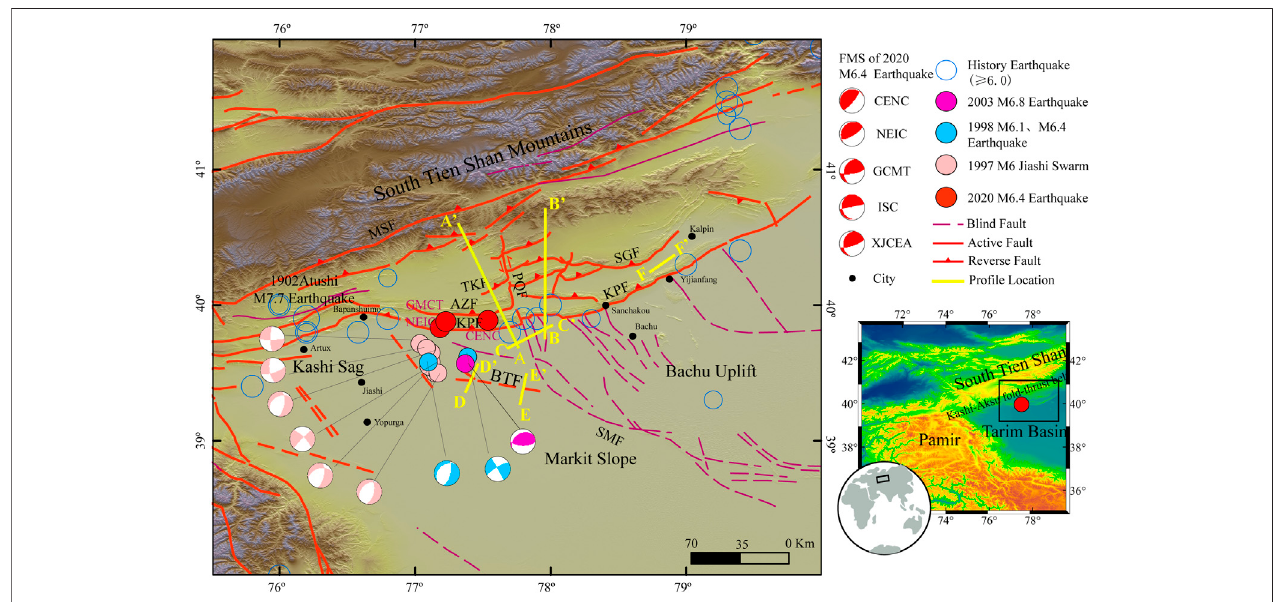
FIGURE 1 | Regional geological settings of the 2020 Jiashi earthquake. The red circles represent the epicenters of the 2020 Jiashi earthquake determined by differentinstitutions.Thebluecircles,thepurplecircles,andthepinkcirclesrepresenttherelocatedepicentersofthe1998M6.1andM6.4Jiashiearthquakes(Guoetal., 2002), the 2003 M6.8 earthquake (Huang et al., 2006), and the 1997 Jiashi earthquake swarm respectively (data from the GCMT catalog, https://www.globalcmt.org/) (MS6.0). The thin blue circles indicate the locations of historical earthquakes (MS6.0) (data from the CENC). The small black dots indicate geographical locations. The thick yellow lines indicate the locations of the sections in Figure 2 . The acronyms used for the faults and organizations are explained as follows: KPF: Kepingtage fault; PQF Piqiang fault; BTF Bashen-Tuopu fault; SMF Selibuya-Mazartagh fault; MSF Maidan-Shayilamu fault; SGF: Saergantage fault; TKF: Tuokesan fault; AZF: Aozitage fault; CENC: China Earthquake Networks Center; NEIC: National Earthquake Information Center; GCMT: Global Centroid-Moment-Tensor; ISC: International Seismological Center; XJCEA: Xinjiang Earthquake Agency, China Earthquake Administration.